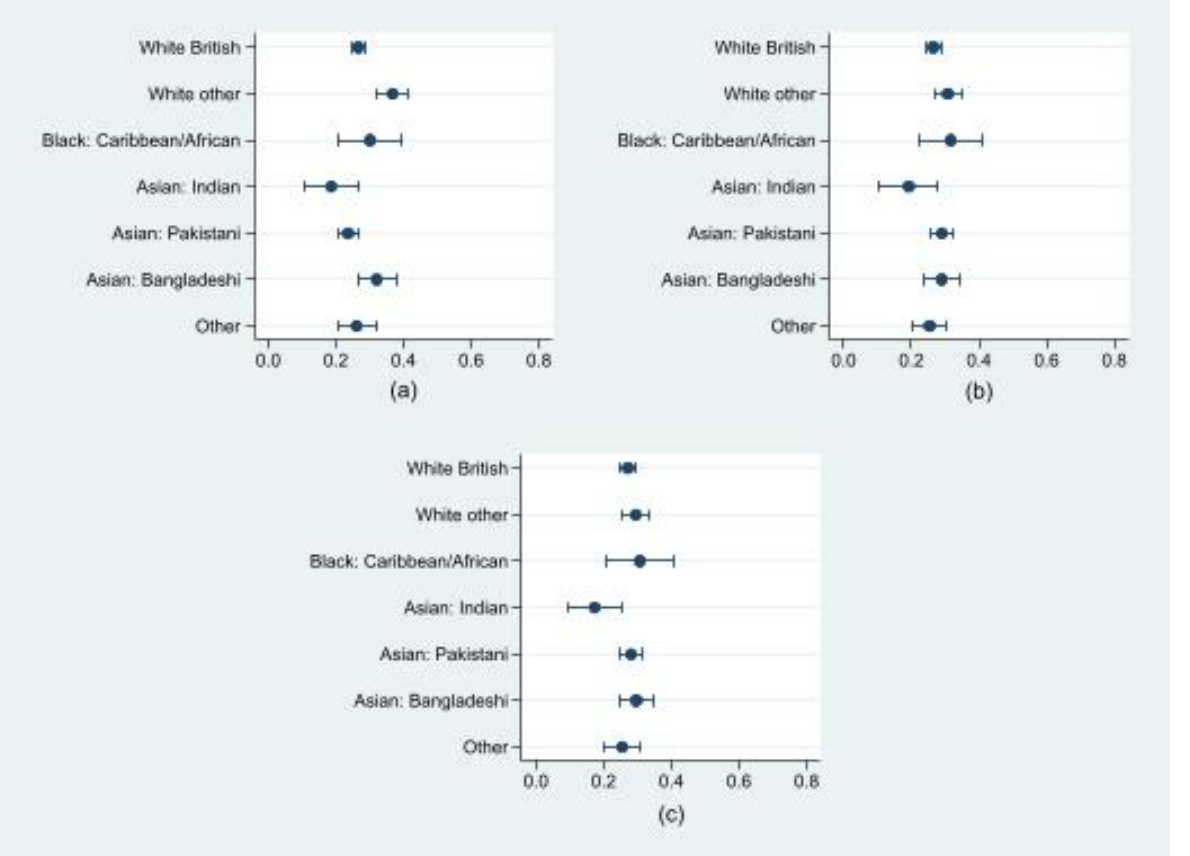
Figure 3. Predictive probability of clinically important depressive symptoms by ethnicity ( n = 2807): ( a ) regression model for the association between ethnicity and depressive symptoms adjusted for loneliness (none of the time (ref), some of the time, most of the time); ( b ) regression model for the association between ethnicity and depressive symptoms adjusted for location of residency (Bradford (ref), London), loneliness (none of the time (ref), some of the time, most of the time) and interaction between ethnicity and loneliness (none of the time (ref), some of the time, most of the time); ( c ) and regression model for the association between ethnicity and depressive symptoms adjusted for location of residency (Bradford (ref), London), loneliness, and social support (high (ref), medium, low), and interaction between ethnicity and loneliness (none of the time (ref), some of the time, most of the time) and ethnicity and social support (high (ref), medium, low).